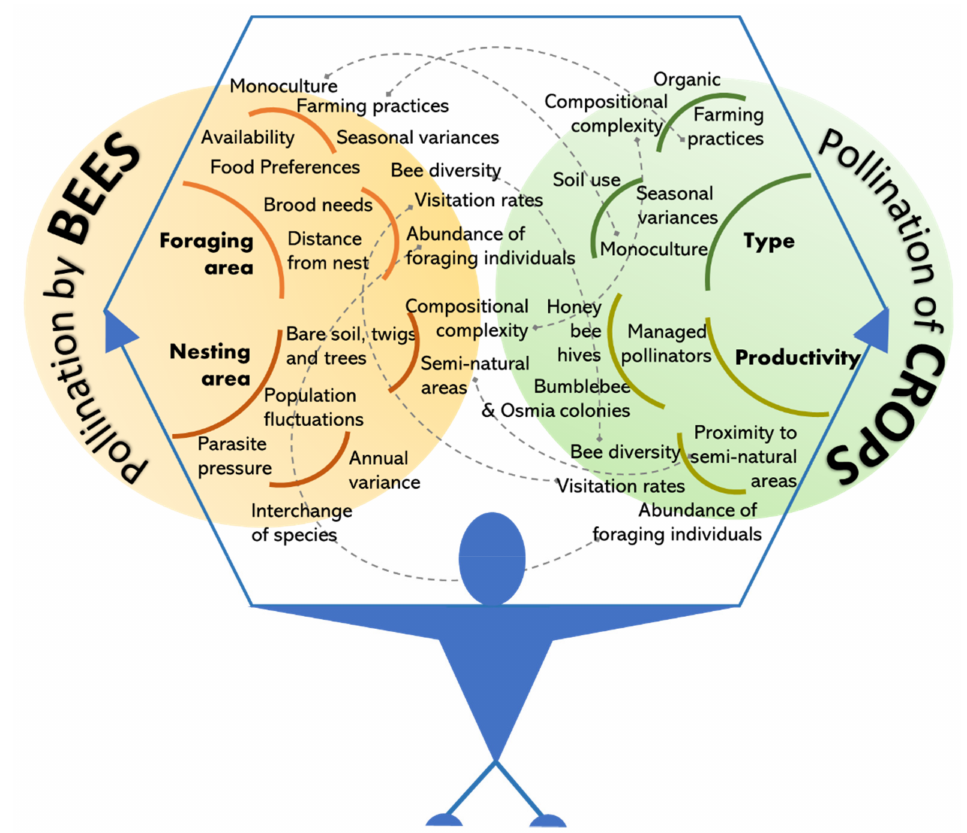
Figure 1. Research perspectives. Opposite but complementary perspectives of research topics addressing pollination in agroecosystems (Section 3). Although the waves of factors may proceed by different paths (green and orange in the figure), the factors themselves are part of a more general context and are placed according to the perspective adopted in a given